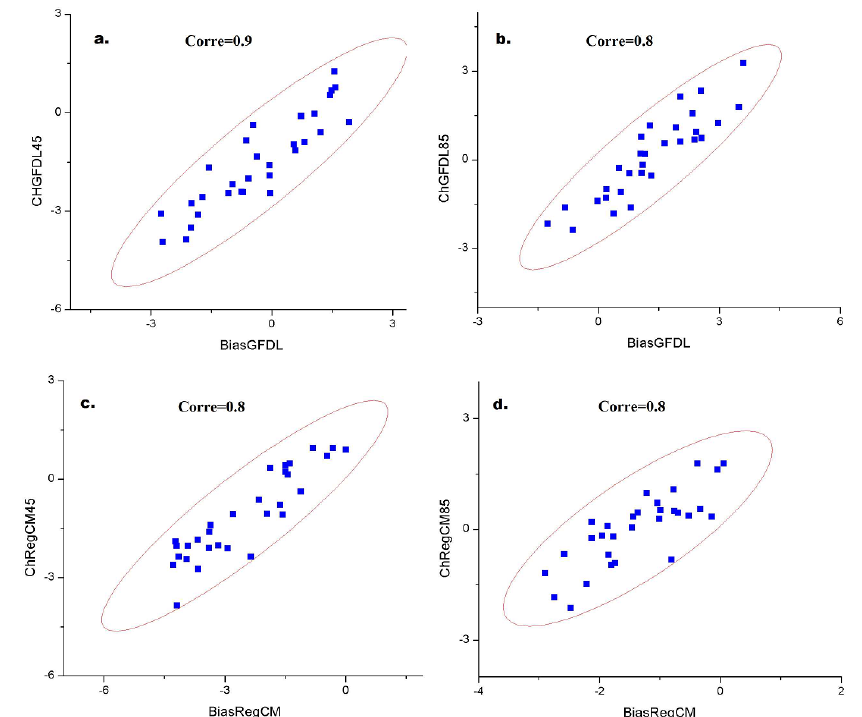
Figure 12. Effect of temperature bias on the projected changes in SASM for GFDL − ESM2M ( a , b ) RegCM4 ( c , d ) under both scenarios. Ellipses indicate that the biases are significant at 95% confidence level.